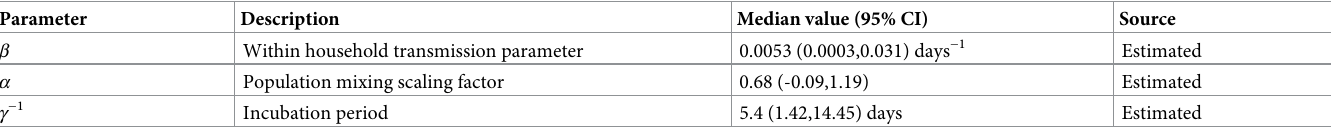
Table 3. The model parameters that were fitted to the data, their values and the 95%